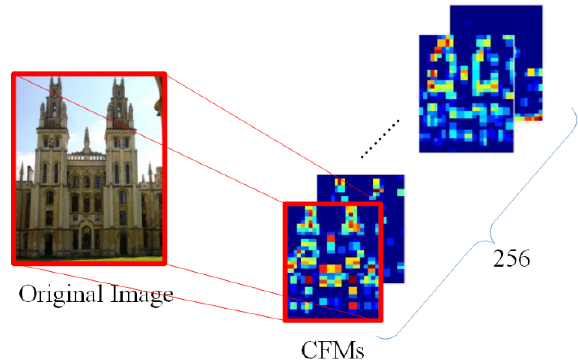
Figure 2. The outputs of the fifth convolutional layer of the AlexNet model, i.e., a set of convolutional feature maps (CFMs), the sizes of which are proportional to the size of the original image.